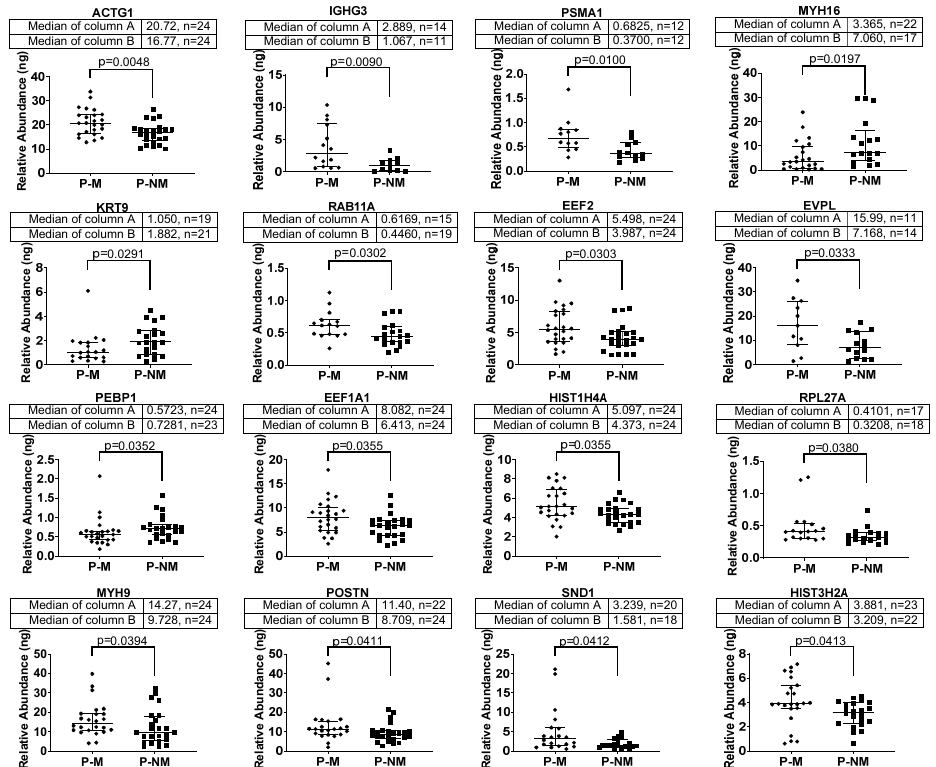
Figure 2. Dot plots showing individual tumour level of expression for each of the 16 significantly di ff erentially expressed proteins in P-M and P-NM melanomas. Expression data for each protein were plotted using Prism, V8 (Graphpad, San Diego, CA, USA).